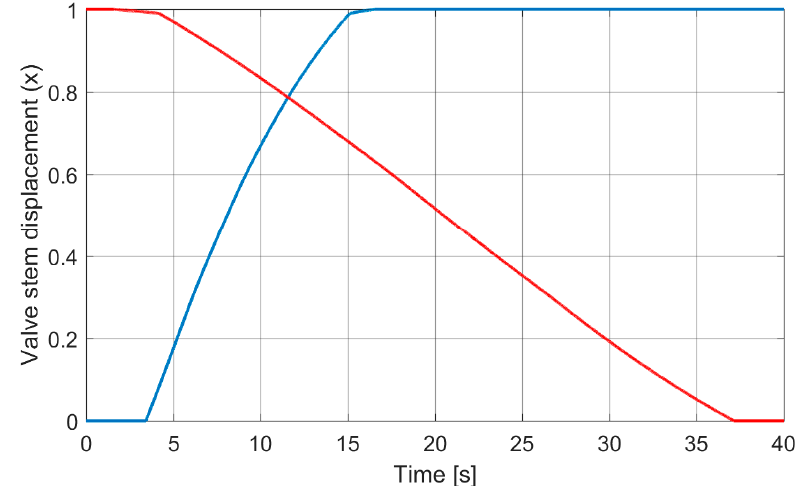
Figure 8. Positive (blue line) and negative (red line) step response of the valve stem displacement of pneumatic actuator.